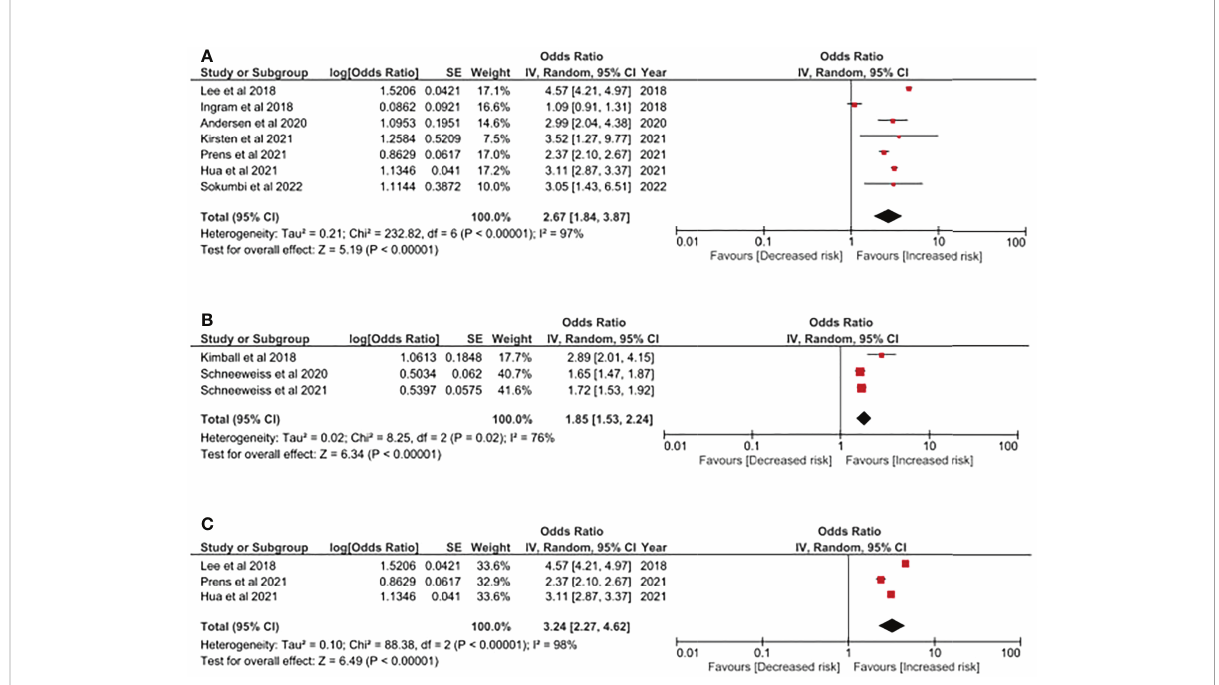
FIGURE 2 (A) Odds ratio of psoriasis in people with Hidradenitis Suppurativa. (B) Sensitivity analysis: Odds ratio of psoriasis in people with Hidradenitis Suppurativa (evidences based on cohort study design). (C) Sensitivity analysis: Odds ratio of psoriasis in people with Hidradenitis Suppurativa in obesity-adjusted models. Legends: Obesity-related factors could serve as critical confounding factors in the pathogenesis in both HS and psoriasis. Thereby, in this model, only studies performing adjustment in obesity-related factors (i.e: BMI, hyperlipidemia, etc.) were